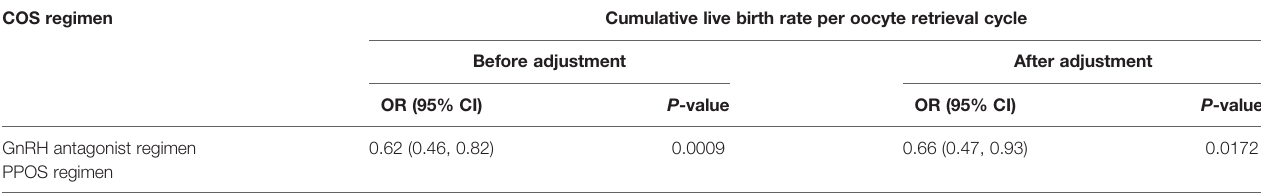
TABLE 3 | Multivariable logistic regression analysis results of the two COS regimen groups and clinical outcomes. COS